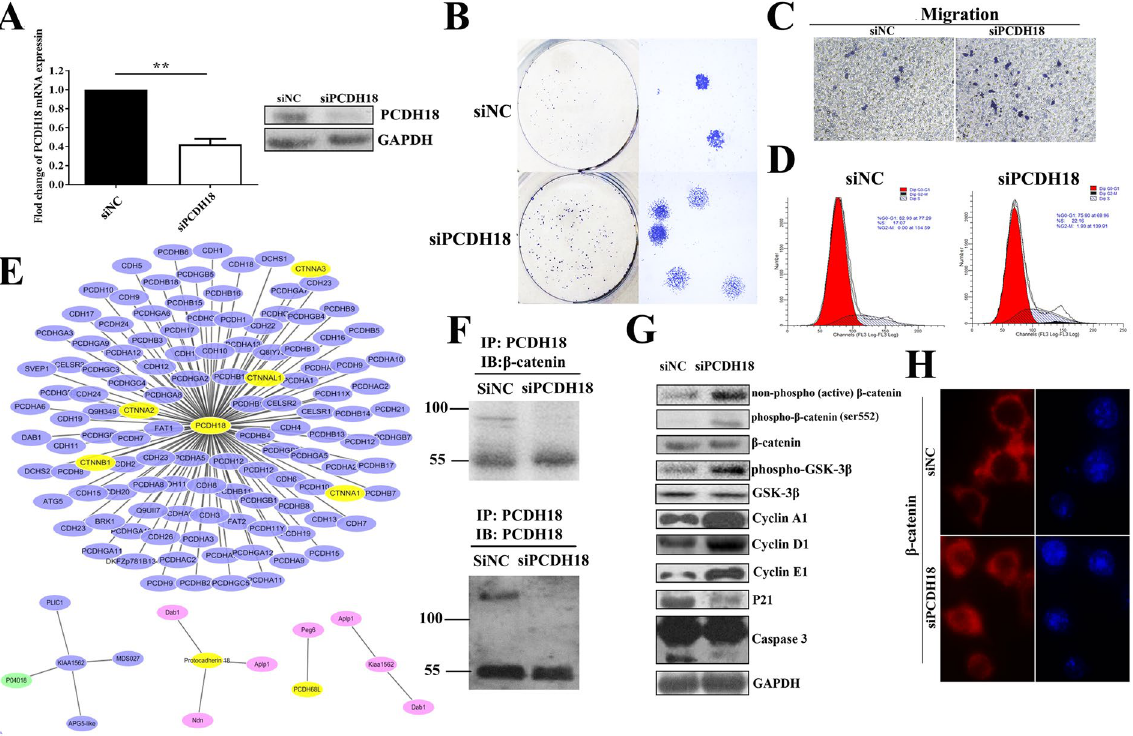
Figure 5. PCDH18 suppression promoted cell migration and proliferation in colonic NCM460 cells through the Wnt/ β -catenin signaling pathway. ( A ) PCDH18 mRNA and protein expression was efficiently inhibited in NCM460 cells transfected with siPCDH18. GAPDH was used as an internal control. ( B ) Representative colony formation assays in NCM460 cells transfected with siRNA-PCDH18 (siPCDH18) and siRNA-negative control (siNC). ( C ) Representative transwell assays in NCM460 cells transfected with siPCDH18 and siNC. ( D ) Cell cycle distribution of NCM460 cells transfected with siPCDH18 and siNC was detected by flow cytometry analysis. ( E ) Molecular interaction networks involving PCDH18 were visualized by Cytoscape3.3.0 software from different species. Blue node represents gene from Homo species. Red node represents gene from Mus species. Green node represents gene from Bos taurus species. ( F ) Protein expression levels of nonphospho (active)- β -catenin, phospho- β -catenin, total- β -catenin, phospho-GSK-3 β , GSK-3 β , p21, cyclin A1, cyclin D1, cyclin E1 and caspase3 in NCM460 cells transfected with siPCDH18 and siNC. ( G ) Representative images of β -catenin staining in NCM460 cells transfected with siPCDH18 and